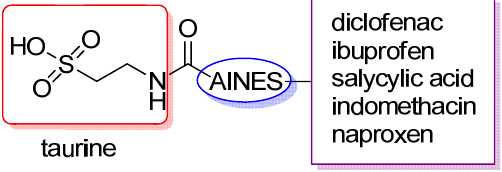
Figure 9. Mutual prodrugs of NSAIDs and taurine with COX and IL-1 inhibition activity without gastrotoxicity.